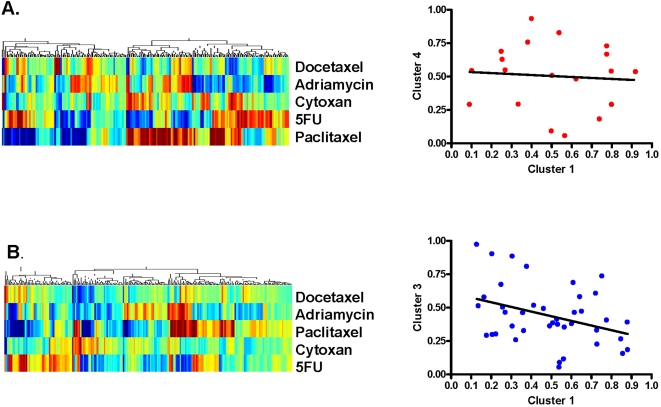
Chemosensitivity patterns among women aged ≤45 years and ≥65 years with early stage breast cancer.A) LEFT PANEL Hierarchical clustering of the probability of sensitivity to 5-fluorouracil (5-FU), paclitaxel, docetaxel, adriamycin and cyclophosphamide among 200 breast tumors arising in women aged ≤45 years; RIGHT PANEL Linear regression analysis of sensitivity to adriamycin among women in genomic cluster 1 (poor prognosis) vs. 4 (good prognosis) aged ≤45 years. B) LEFT PANEL Hierarchical clustering of the probability of sensitivity to 5FU, paclitaxel, docetaxel, adriamycin and cyclophosphamide among 211 breast tumors arising in women aged ≥65 years. RIGHT PANEL Linear regression analysis of sensitivity to adriamycin among women in genomic cluster 1 (poor prognosis) vs. genomic cluster 3 (good prognosis), demonstrating a statistically significant (p = 0.02, log rank) relationship between clusters (of pathway deregulation) and adriamycin sensitivity.